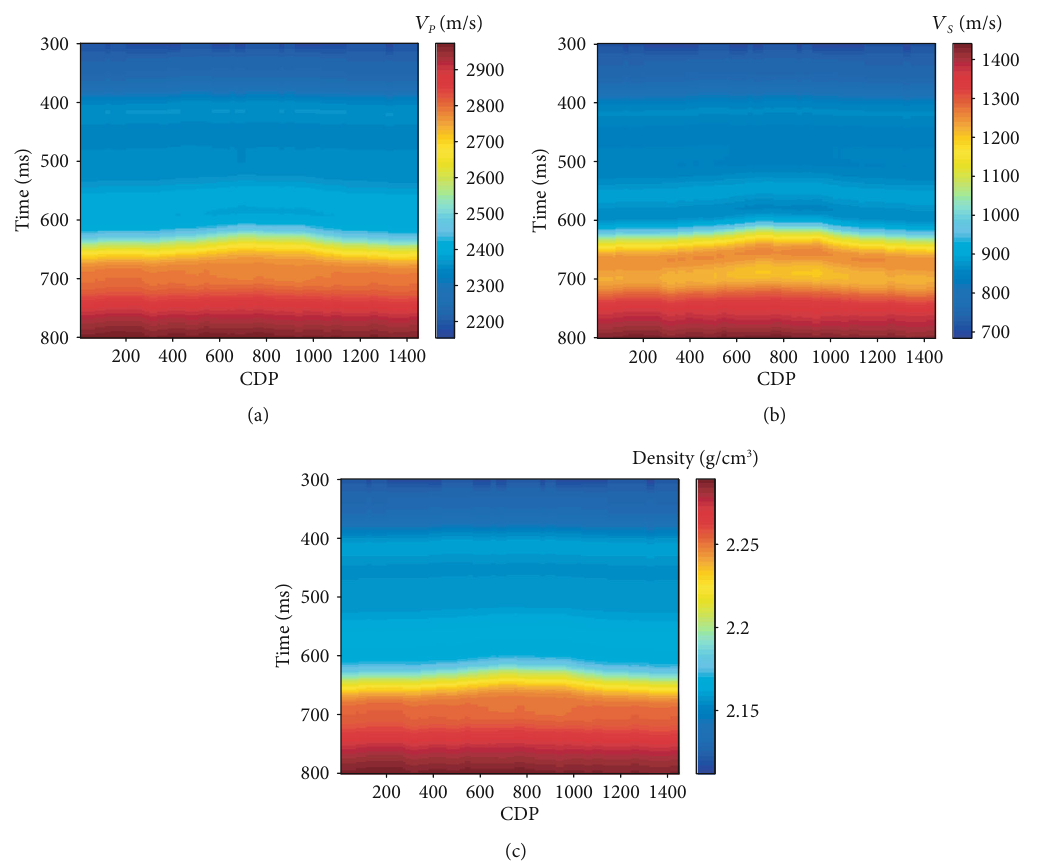
Figure 11: The initial model of (a) P-wave velocity, (b) S-wave velocity, and (c) density from the well log